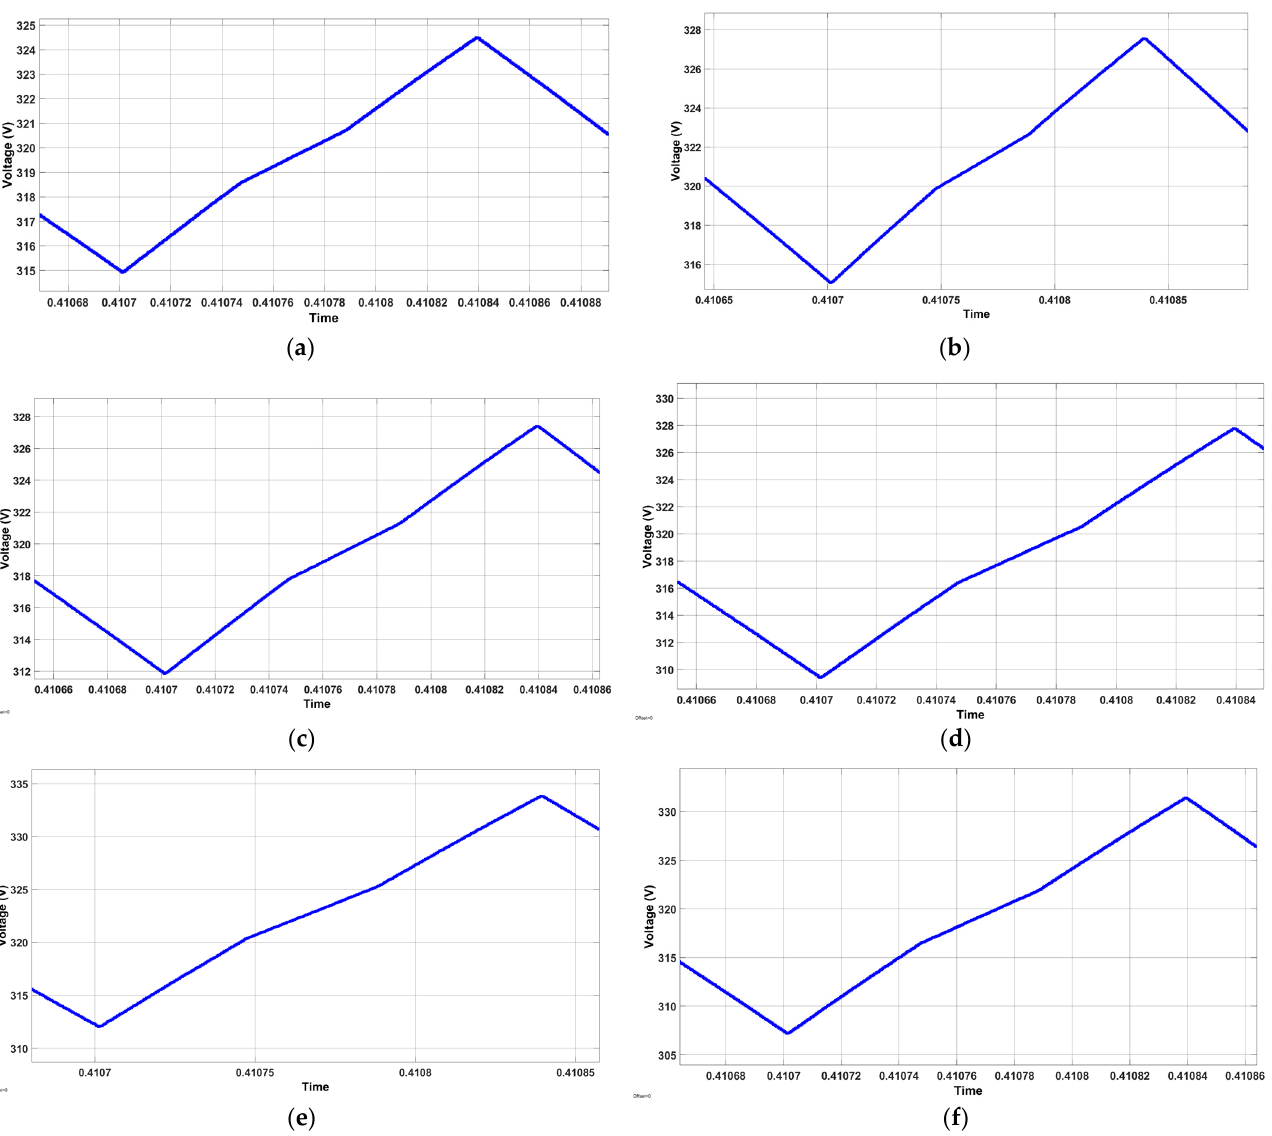
Figure 12. Voltage ripples obtained in simulation, using the capacitance with the proposed equation: ( a ) 3%; ( b ) 4%; ( c ) 5%; ( d ) 6%; ( e ) 7%; ( f ) 8%. Table 8. Capacitance values using existing equations and the proposed equation, with a 3% voltage ripple. Equation